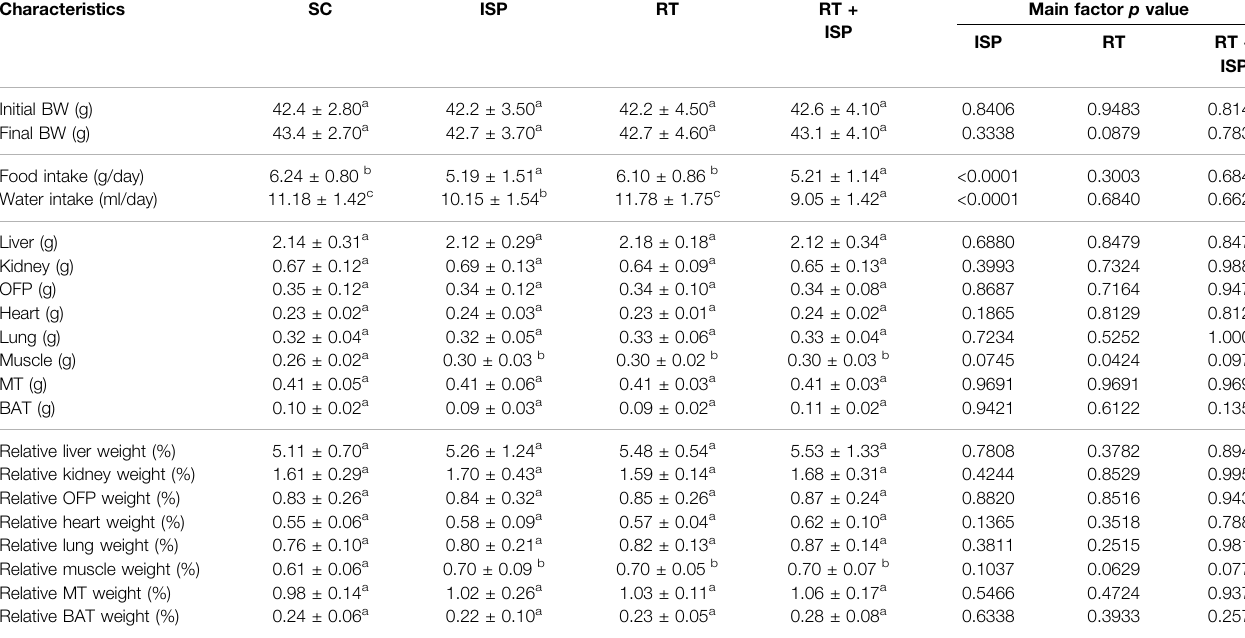
TABLE 2 | General characteristics of the experimental groups.